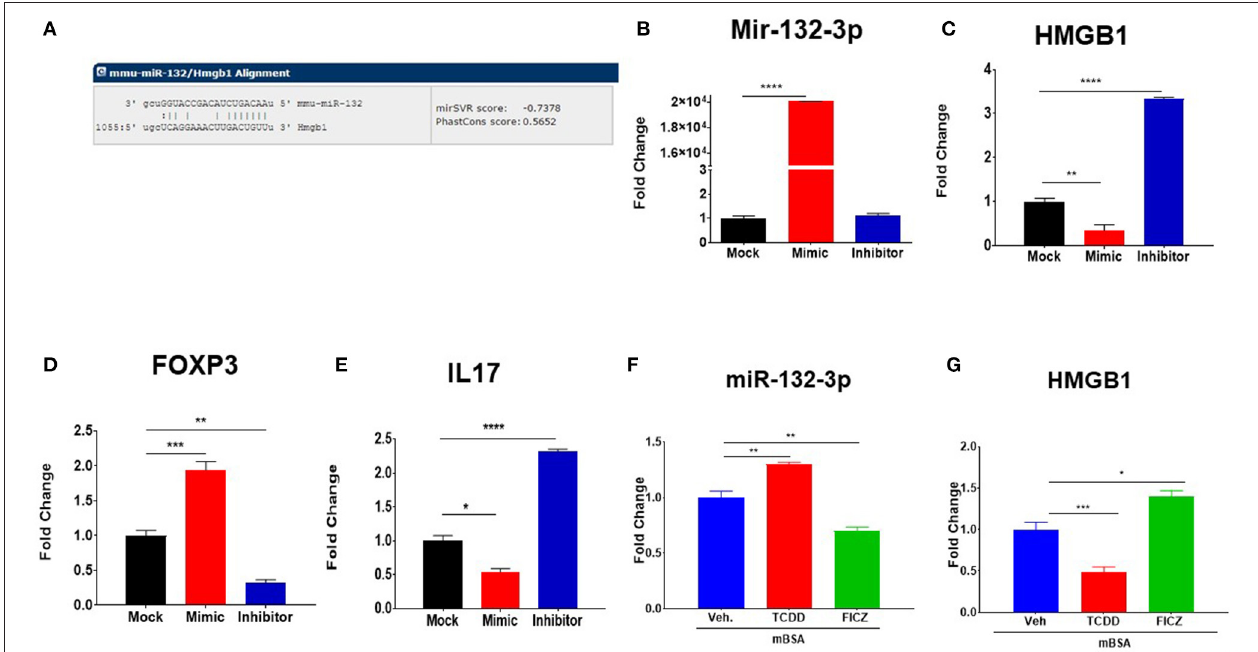
FIGURE 7 | Transfection and alignment studies to investigate the targets of miR-132-3p. (A) Using sequence microrna.org miR-132-3p was highly predicted to target mRNA for HMGB1. DTH was induced as described in Figure 1 legend and DLN cells from mBSA-induced DTH mice were transfected with either scrambled miRNAs (Mock) or with mature miR-132-3p mimic or miR-132-3p as described in Methods. After transfection, the cells were incubated at 37 ◦ C for 24h and analyzed for gene expression and miRNAs validation. (B) qRT-PCR based expression of miR-132-3p. (C) qRT-PCR-based expression of HMGB1. (D) qRT-PCR based expression of FoxP3. (E) qRT-PCR based expression of Il-17. (F,G) Naïve mice were treated with TCDD and FICZ and lymph node cells were tested using q-RT-PCR on the expression of miR-132-3p and HMGB1. Vertical bars represent Mean ± SEM and significant differences between groups are shown with asterisks (* p < 0.05, ** p < 0.01, *** p < 0.001, **** p < 0.0001) based on one-way